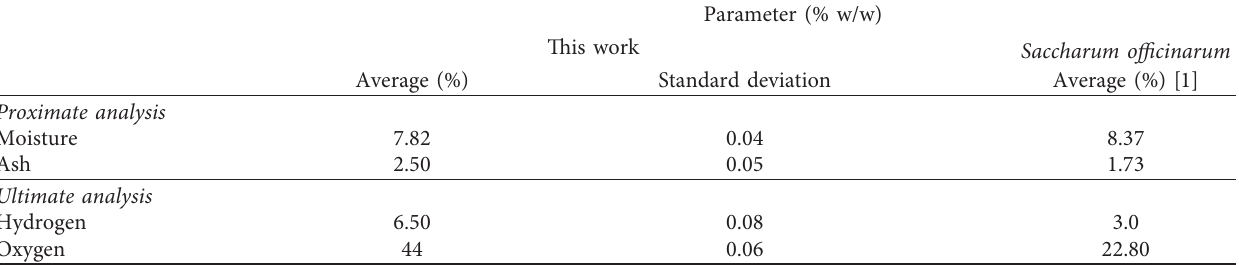
Table 1: Proximate and ultimate analyses of sugarcane bagasse waste materials.